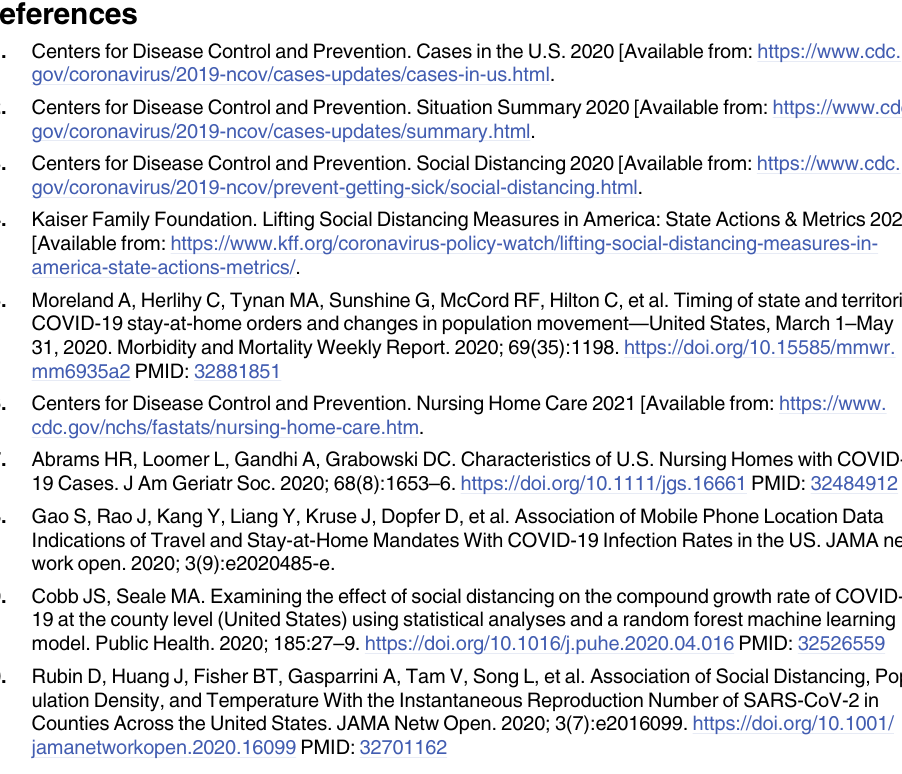
S1 Table. Additional information on model parameters and goodness of